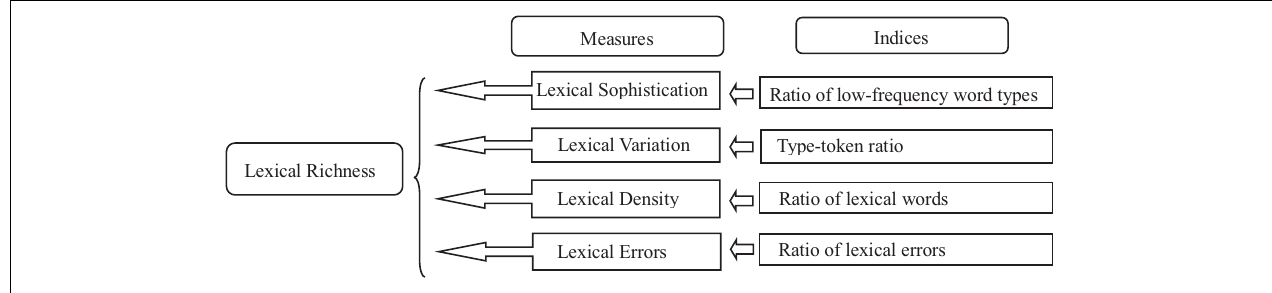
FIGURE 2 | Multidimensional model of lexical